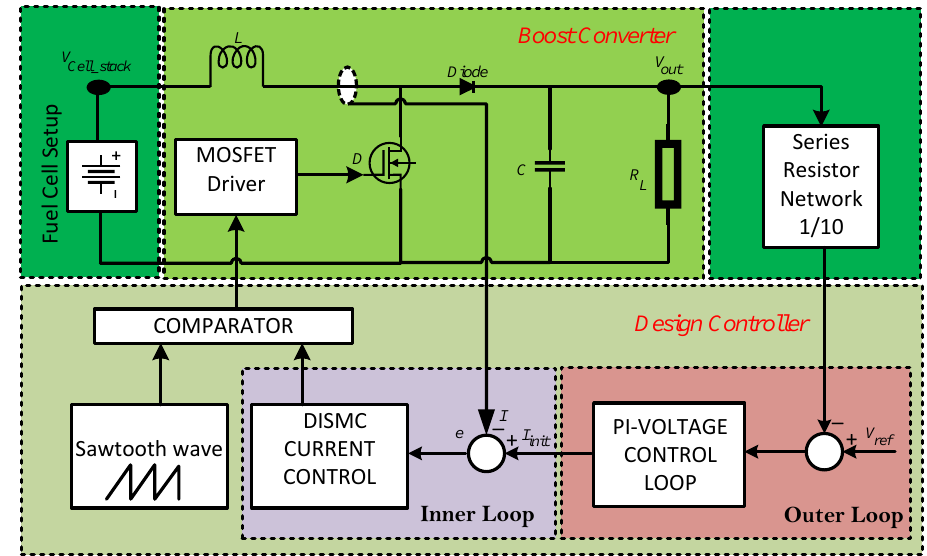
Figure 2. Block diagram of power control